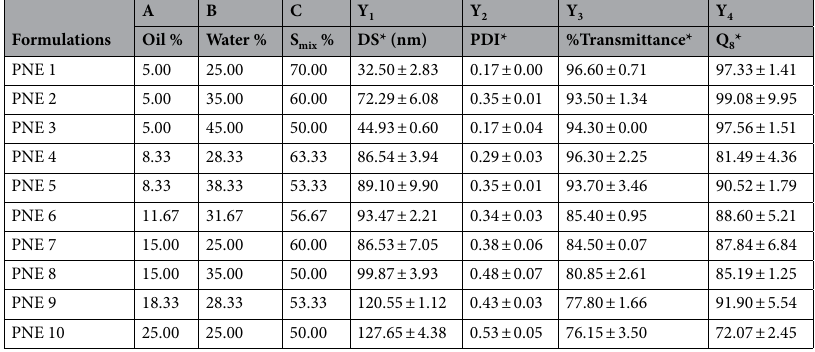
Table 1. Composition of the prepared PNEs and their observed responses. * Mean ± Standard deviation (n = 3). Abbreviations: PNE, Phytonanoemulsion; S mix , Surfactant/Cosurfactant mixture; DS, Droplet size; PDI, Polydispersity index; Q 8 , The cumulative percent of SAH released in 8